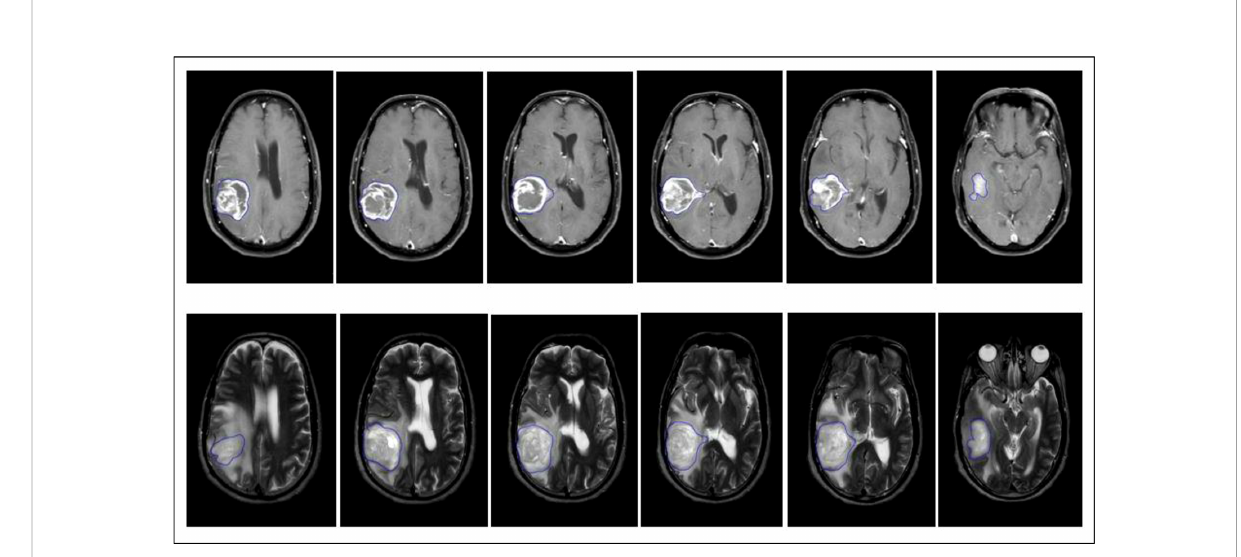
FIGURE 2 Representative multi-slice region of interest (ROI) of an IDH wild-type GBM done on axial T1 + C and T2 MR Images using slice-by-slice image segmentation.